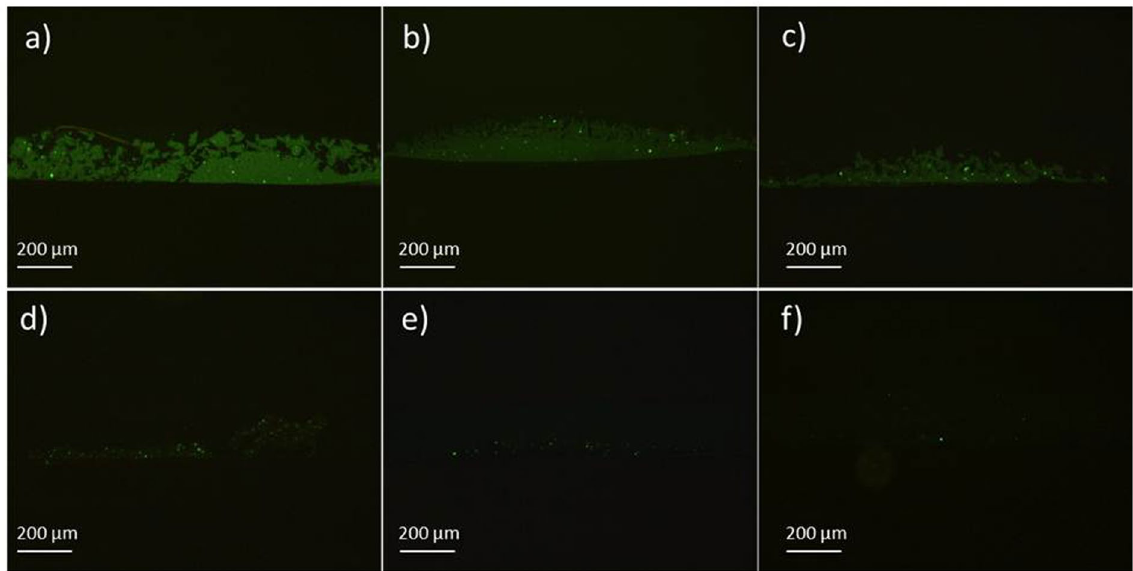
Figure 8. Fluorescence images of the concentrated immunocomplexes on the sensing zone of 1–3 set-up for samples of ( a ) 20 nM, ( b ) 10 nM, ( c ) 5 nM, ( d ) 3 nM, ( e ) 1.5 nM and ( f ) 0.7 nM PSMA protein concentrations in the buffer